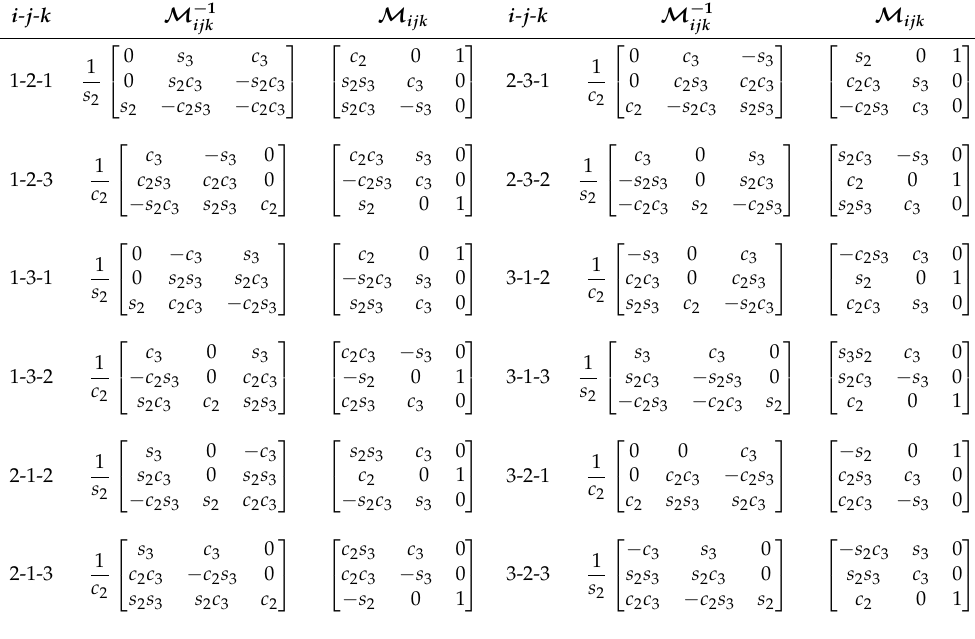
Table A1. Angular velocity error vector and Euler angle error rates mapping.